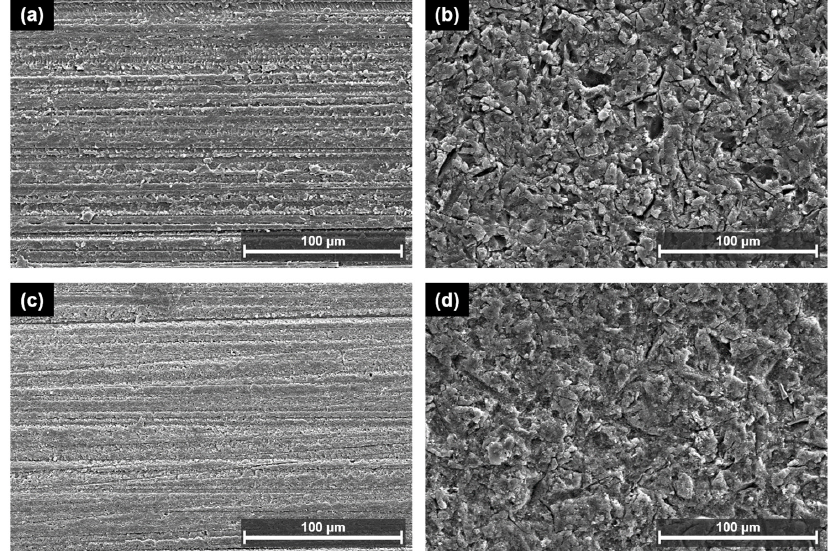
Figure 6. Low-magnification (×500) scanning electron microscopy (SEM) images of both types of 3D printing resins for different surface treatments: ( a ) No surface treatment of Group 1; ( b ) APA of Group 1; ( c ) no surface treatment of Group 2; and ( d ) APA of Group 2